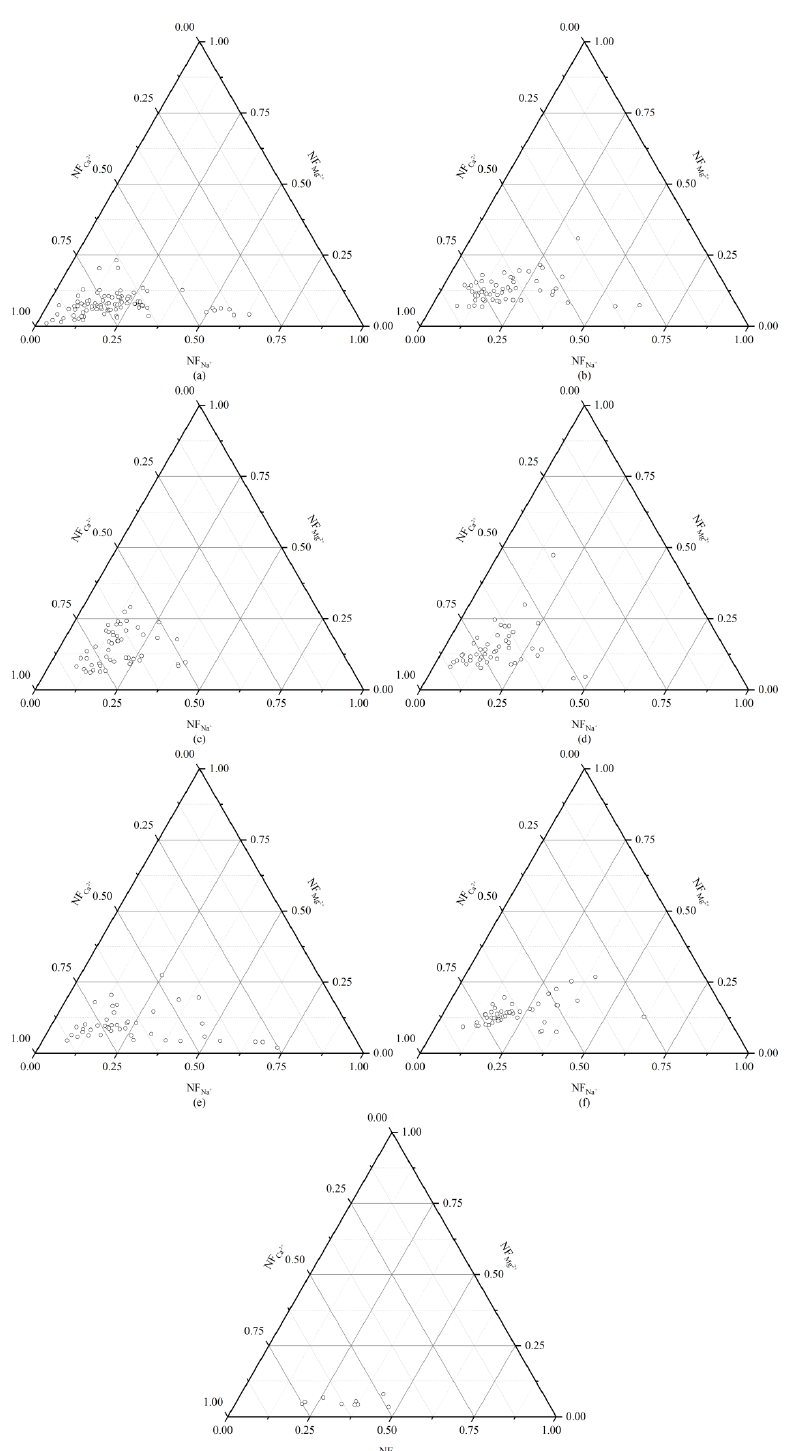
Figure 6. Triangular diagrams of NF for Na + , Mg 2+ and Ca 2+ ( a ) Lenglong, ( b ) Ningchang, ( c ) Huajian, ( d ) Xiying, ( e ) Yangjiazhuang, ( f ) Zhuaxixiulong, ( g ) Qilian.